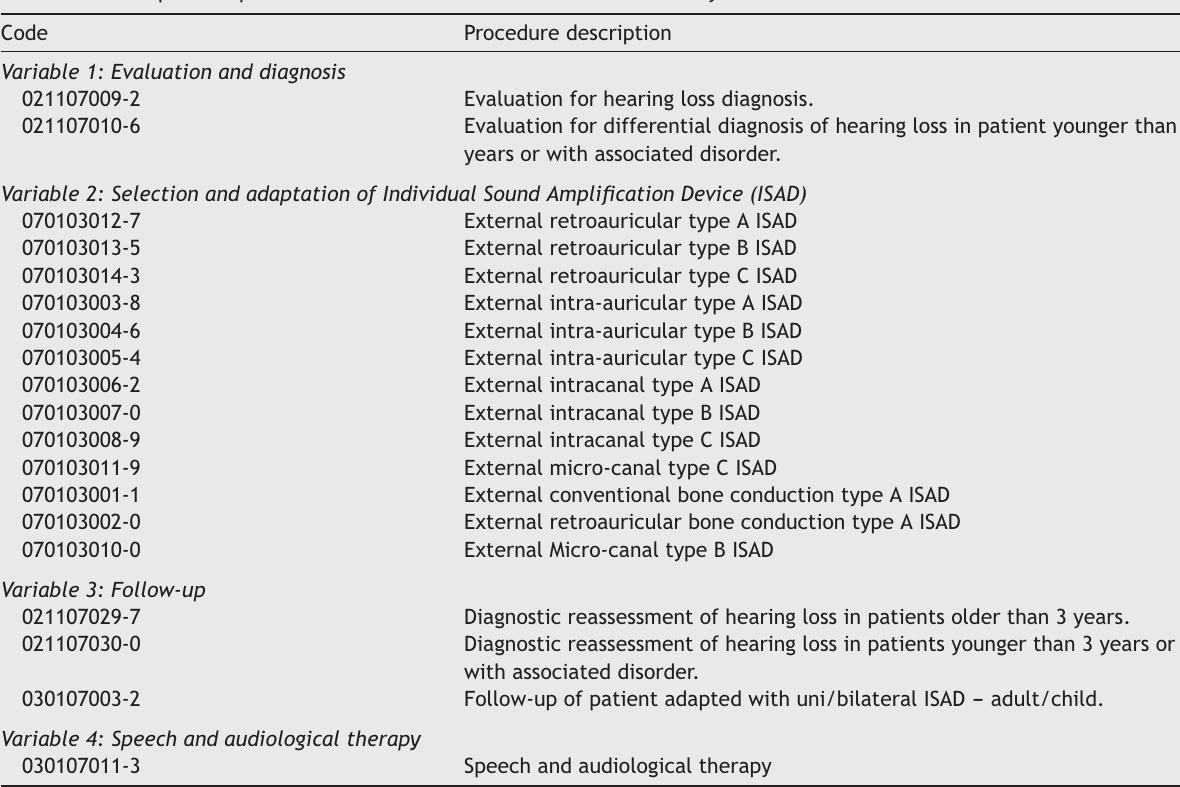
Table 1 Description of procedures considered for calculation of the study